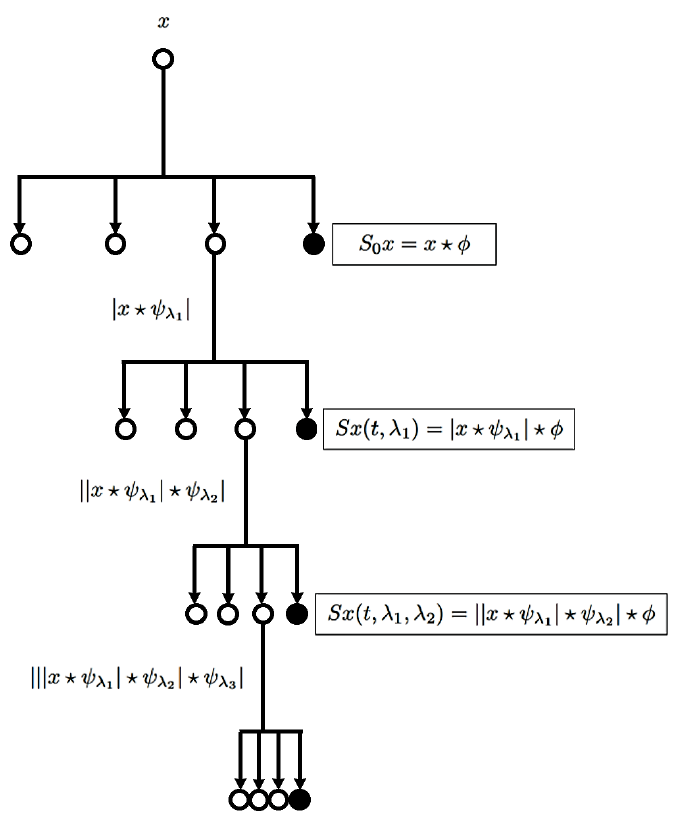
Figure 1. A wavelet scattering transform iterates on a set of wavelet modulus operators to compute cascades of wavelet convolutions and moduli, generating averaged scattering